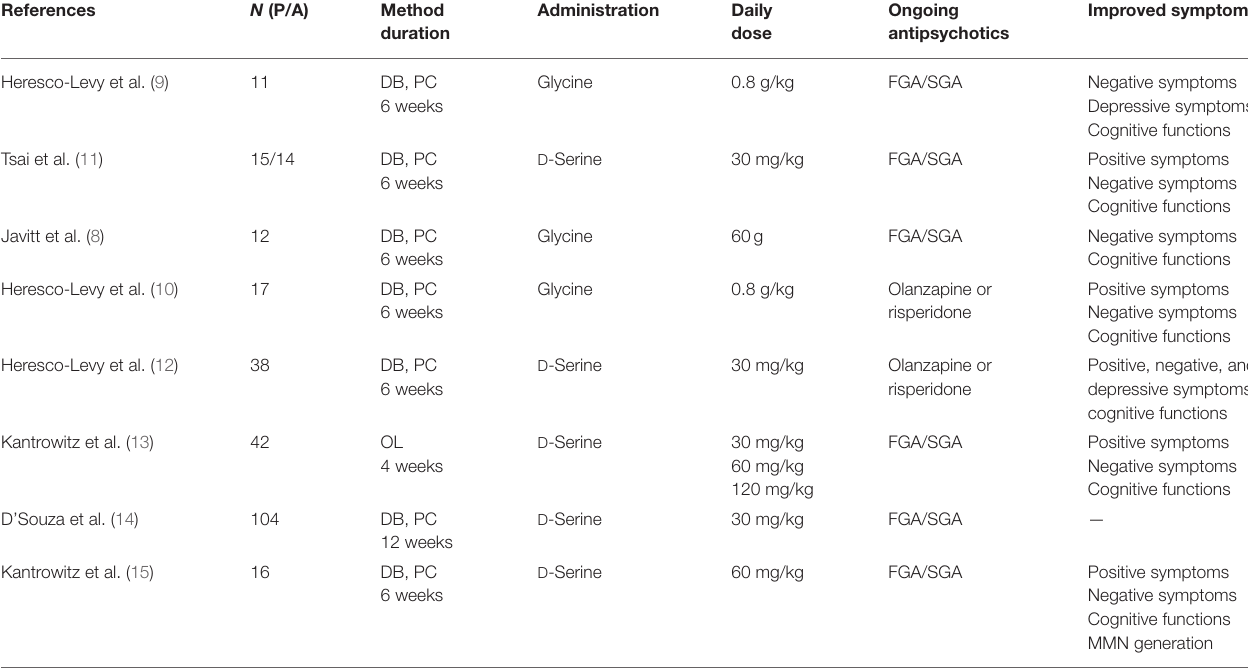
TABLE 1 | D -Serine and glycine in augmentation of treatment with antipsychotics in patients with schizophrenia—results of the clinical